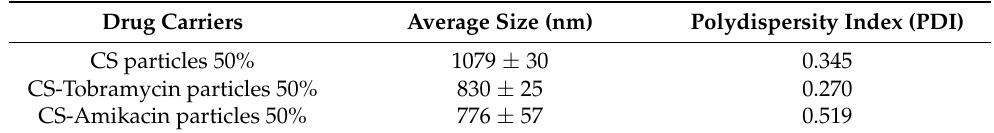
Table 1. Hydrodynamic average size and polydispersity index values of CS, CS-Tobramycin, and CS-Amikacin particles crosslinked at 50% mole ratio.